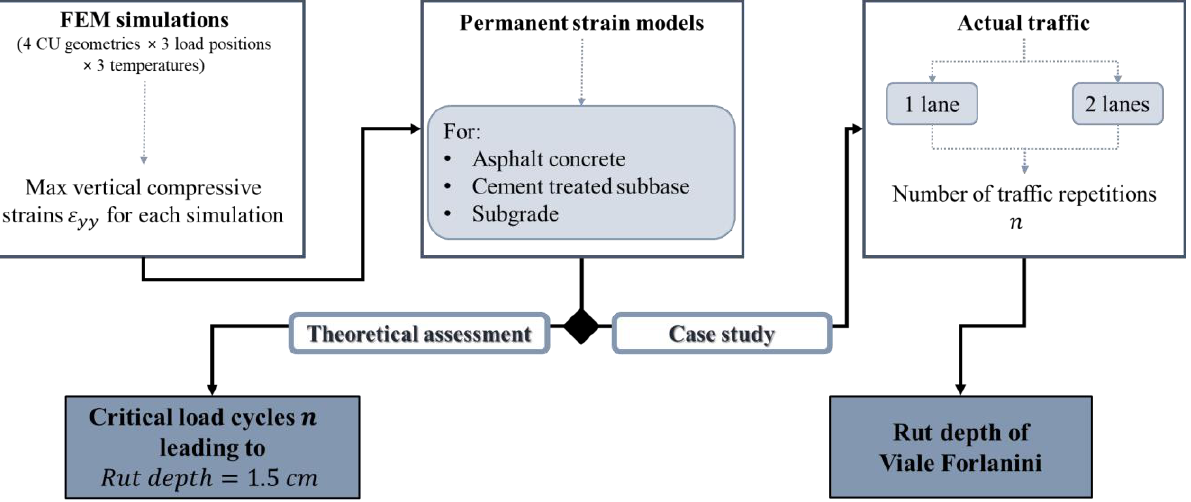
Figure 5. Experimental plan flow chart regarding rutting assessment. In line with the previous